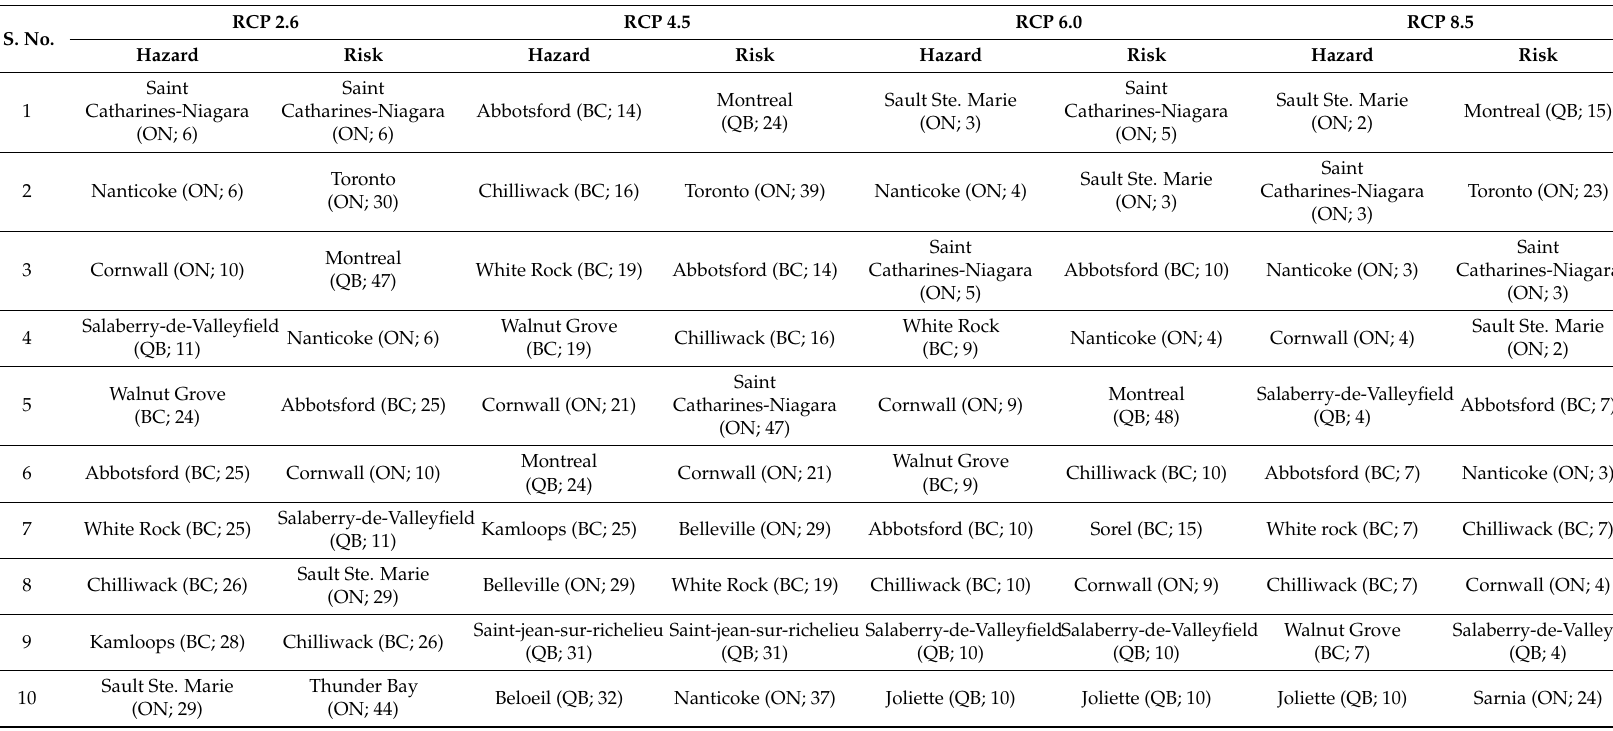
Table 5. Ten cities projected with most increases in flood-hazard and flood-risk of historical 100-year return period floods in future obtained from all GCM median approach. Information on the province and projected future flood frequency magnitudes in years is also provided within brackets. S.